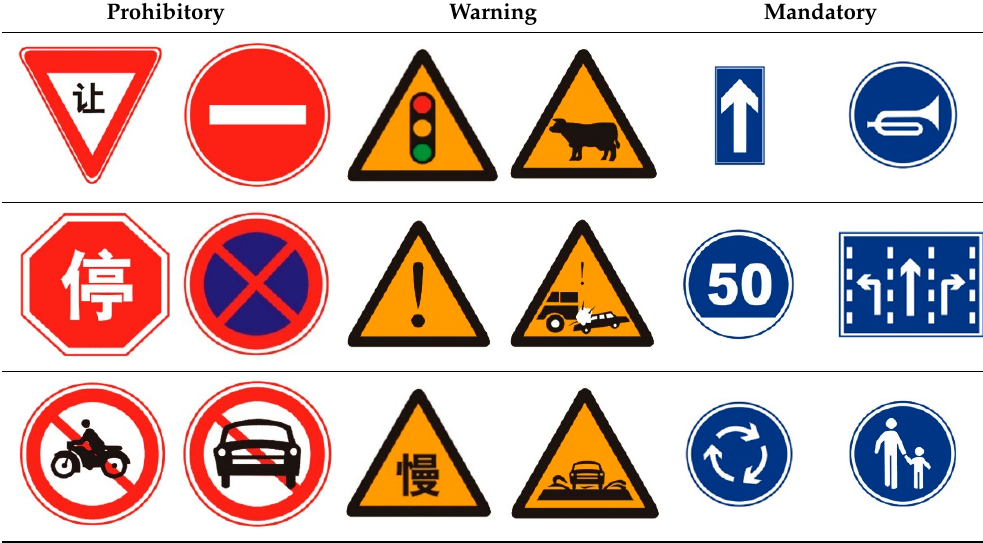
Table 1. Selected examples of three types of traffic signs in the CCTSDB2021 dataset.